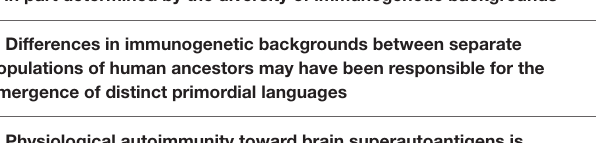
TABLE 5 | Prospective ideas on autoimmunity-driven cognitive TABLE 4 | GWAS (genome-wide association studies) associate MHC class II genes with brain-related disorders or traits. Brain disorders Behavioral or cognitive traits